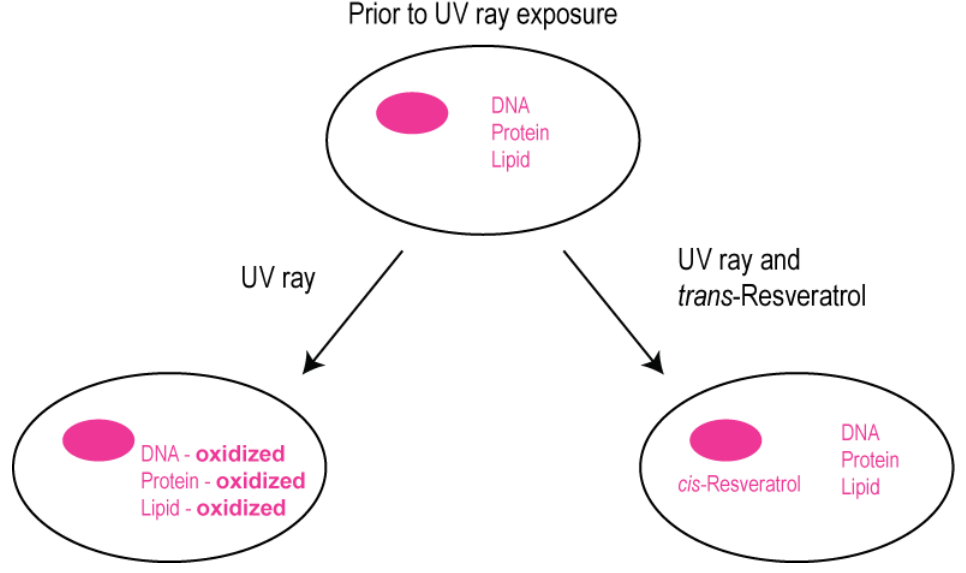
Figure 3. Resveratrol protects RPE cells from UV damage . Trans -resveratrol